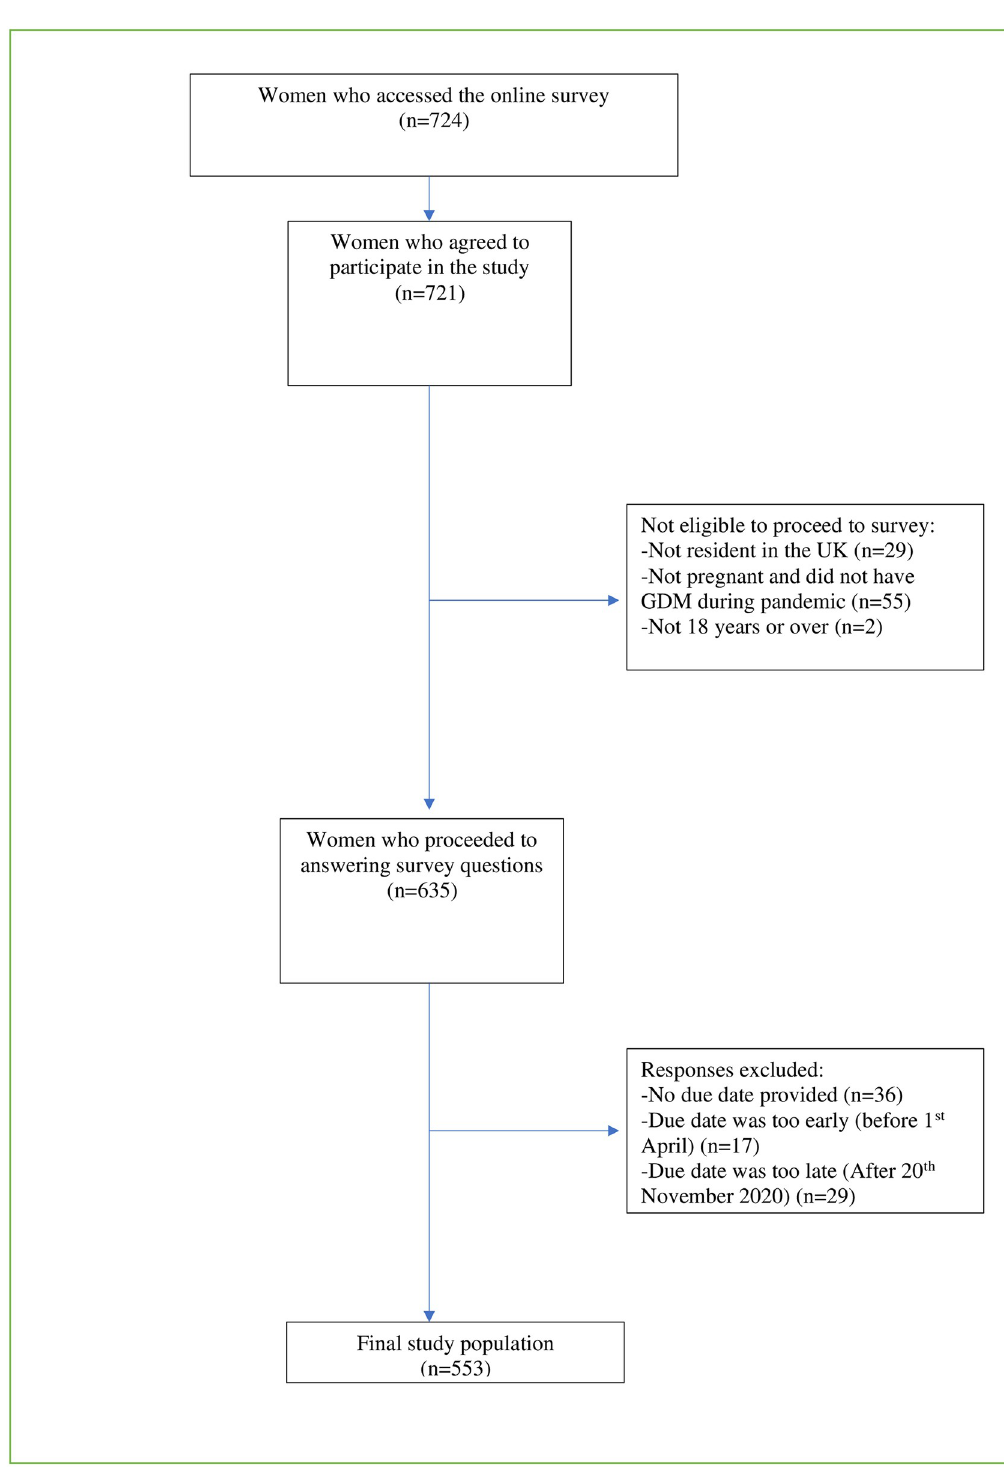
Fig 1. Participant flow chart to achieve study sample.